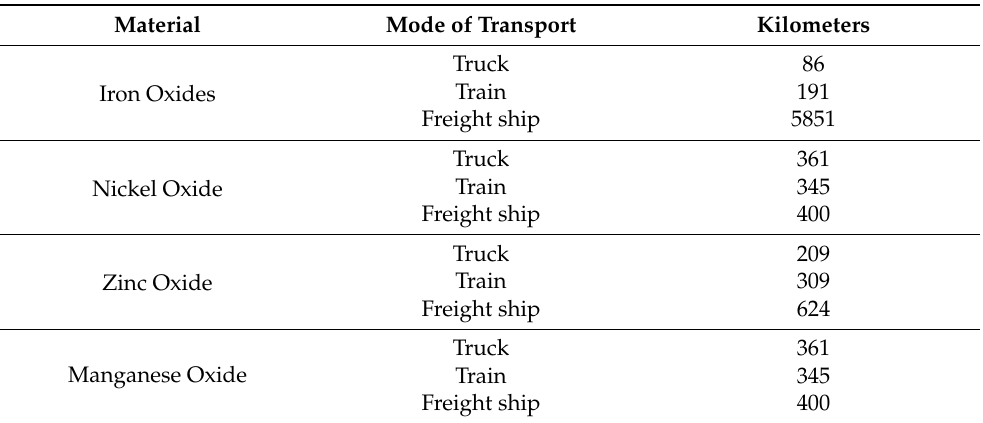
Table 7. EcoInvent distances and mode of transportation from suppliers to the manufacturing